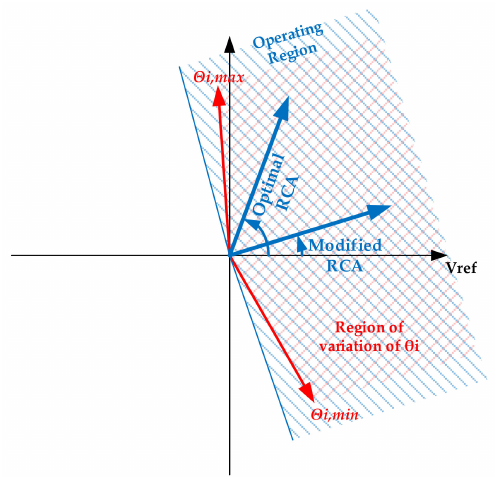
Figure 6. Example of modified RCA for improved detection